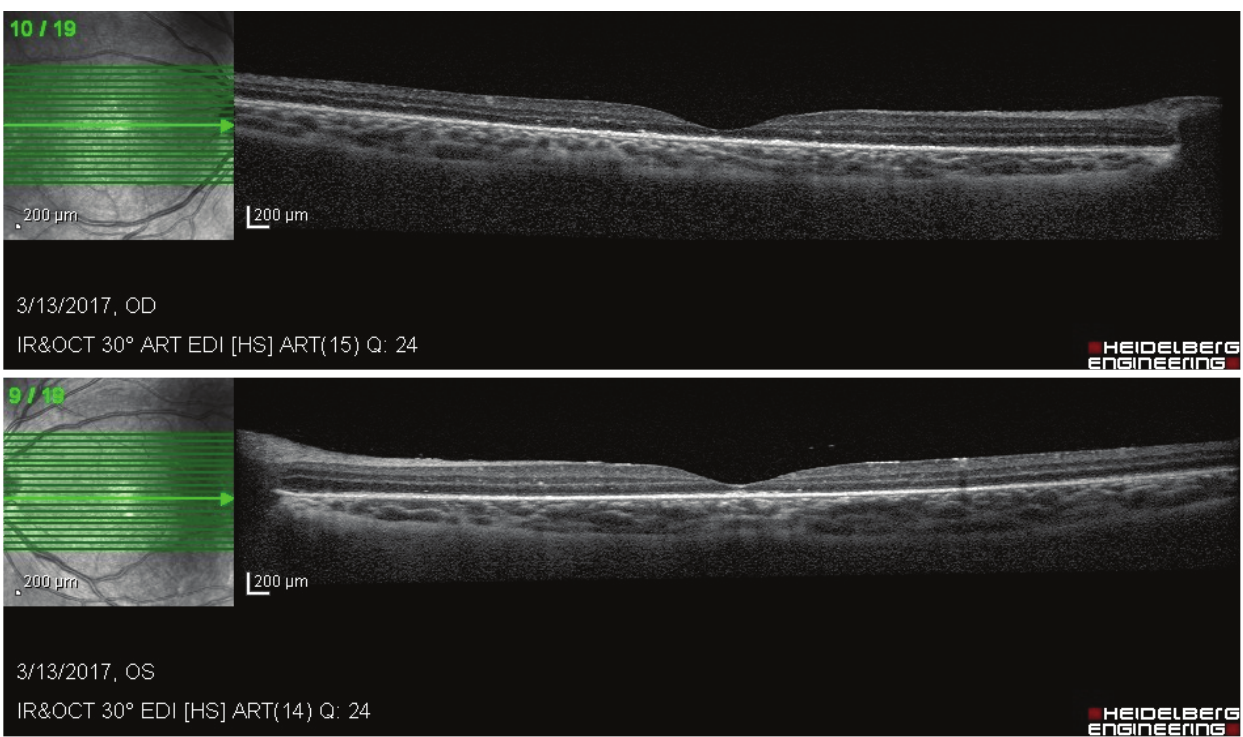
Figure 4. Macular OCT image shows complete resolution of the retinal exudates and subretinal fluids. The central macular thickness of the right and left eyes is 188 and 183 µm,